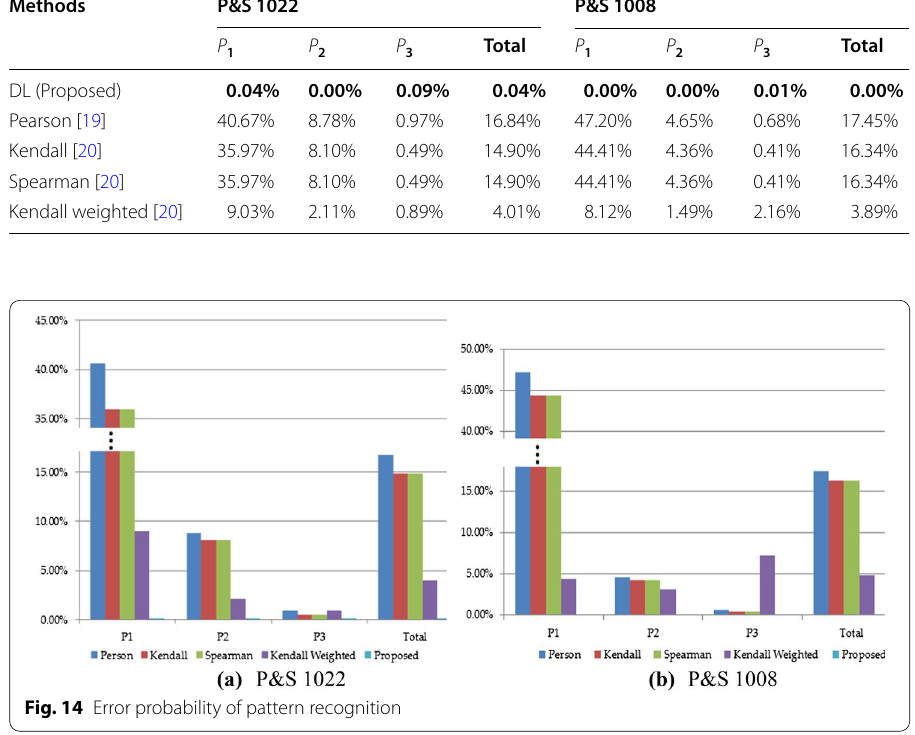
Fig. 14 Error probability of pattern